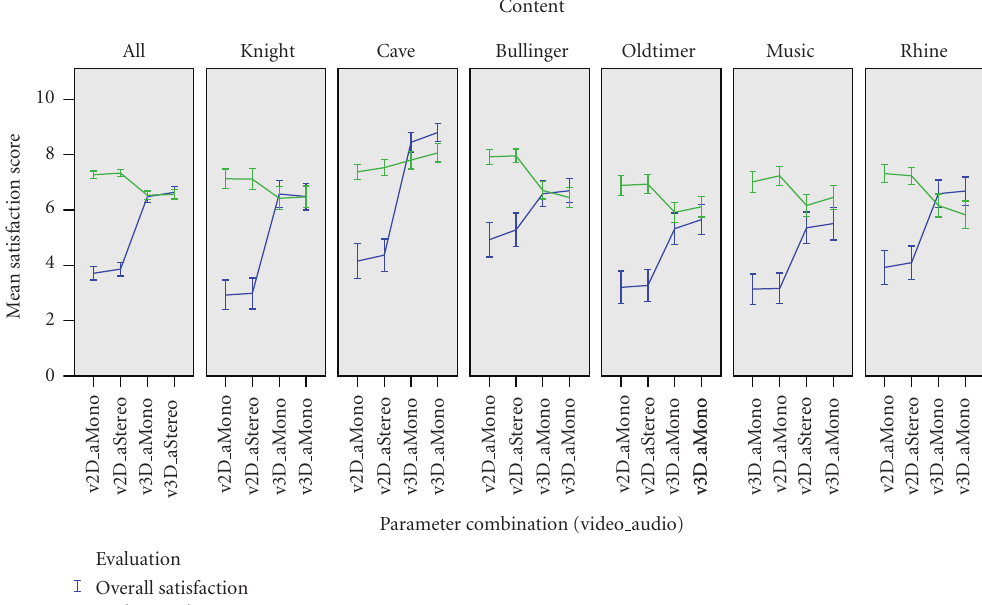
Figure 9: Results for overall quality and 3D impression. The bars show 95% CI of